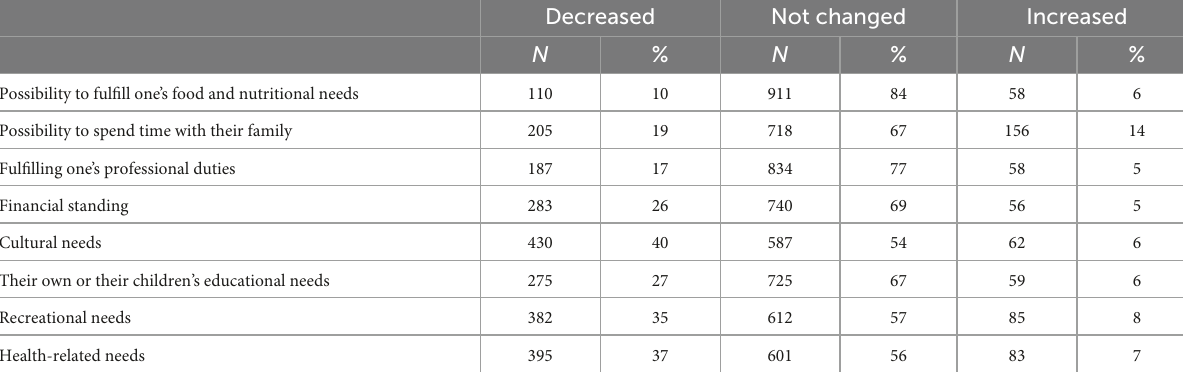
TABLE 3 The influence of pandemic on the possibility to fulfill one’s needs.